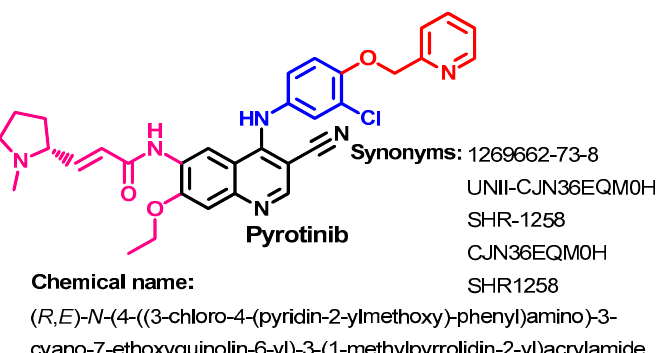
Figure 57. Chemical structure, name, and synonyms of pyrotinib.